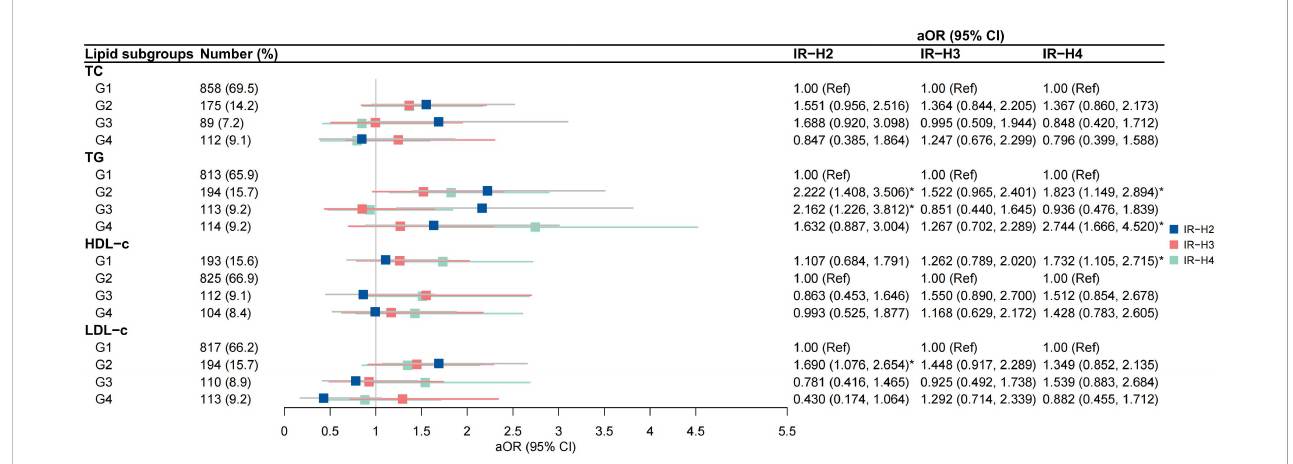
FIGURE 4 Associations between trends in lipid pro fi les and trends in insulin resistance calculated by HOMA-IR IR-H2, pregnancies with persistently high HOMA-IR in both the fi rst and second trimesters; IR-H3 group, pregnancies with fi rst-trimester high HOMA-IR alone; IR-H4 group, pregnancies with second- trimester high HOMA-IR